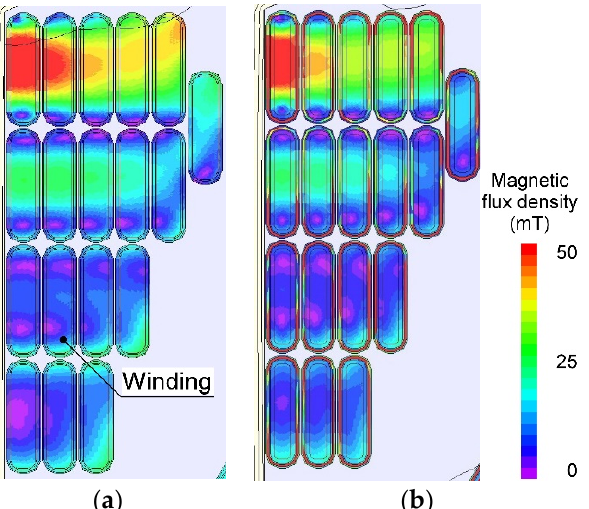
Figure 9. Distributions of magnetic flux density in the ( P o = 10 kW, N r = 10,000 rpm, θ e = 69°) ( a ) rectangular winding; ( b ) magnetic tape-wrapped winding.